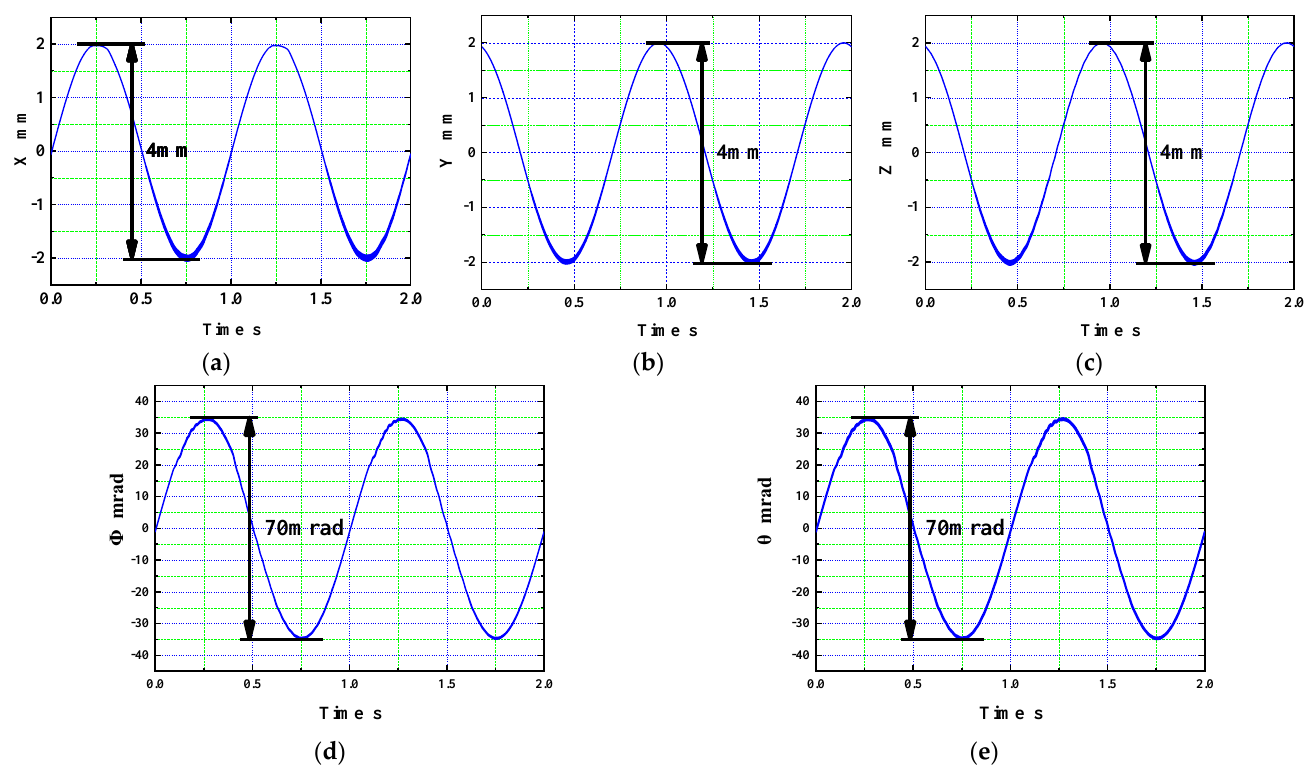
Figure 15. Positioning resolutions. ( a ) The stroke in the X direction; ( b ) The stroke in the Y direction; ( c ) The stroke in the Z direction; ( d ) The s troke in the Φ direction; ( e ) The stroke in the θ direction. Fourth, the X, Y, and Z axis directions and to evaluate the frequency response of Φ, θ directions. The frequency response was measured by a frequency response analyzer (FRA 5095, NF Corp., Yokohama, Japan), and the experimental results are shown in Figure 16. Actuator X, Y, and Z direction of the bandwidth is 101 Hz, 101 Hz, and 51 Hz, respec- tively. The bandwidth of Φ, θ direction was, respectively, 42 Hz, 45 Hz. Based on the above experimental results, the performance evaluation results of the brake are shown in Table 3.